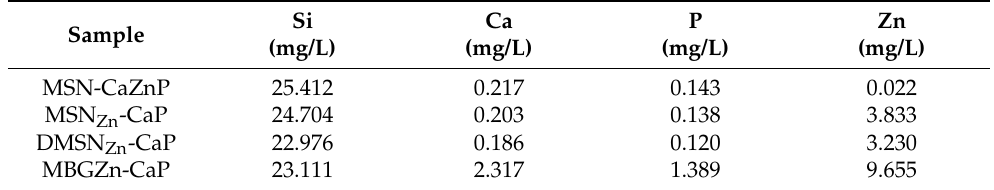
Table 2. Ion composition of 100 mg/L of MSN-CaZnP, MSN Zn -CaP, DMSN Zn -CaP and MBGZn-CaP using ICP-MS analysis.